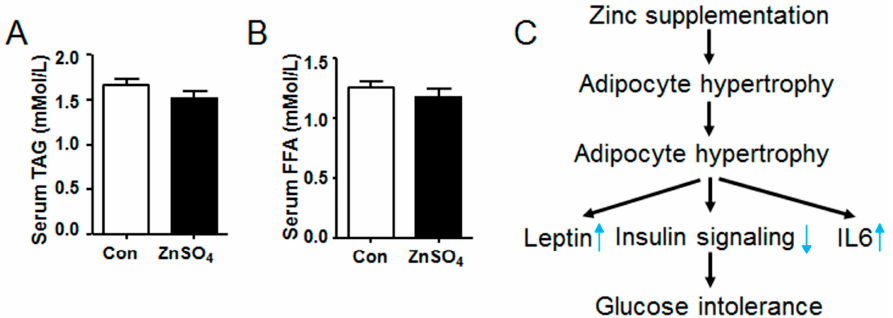
Figure 7. Chronic zinc supplementation did not affect serum levels of triglyceride and free fatty acid. ( A ) Serum triglyceride levels; ( B ) Serum free fatty acid levels; ( C ) The illustration of chronic zinc supplementation inducing adipose tissue hypertrophy. N = 8 for each group. Data were shown as mean ± SEM. Con, control group; ZnSO 4 , zinc sulfate-supplemented group.